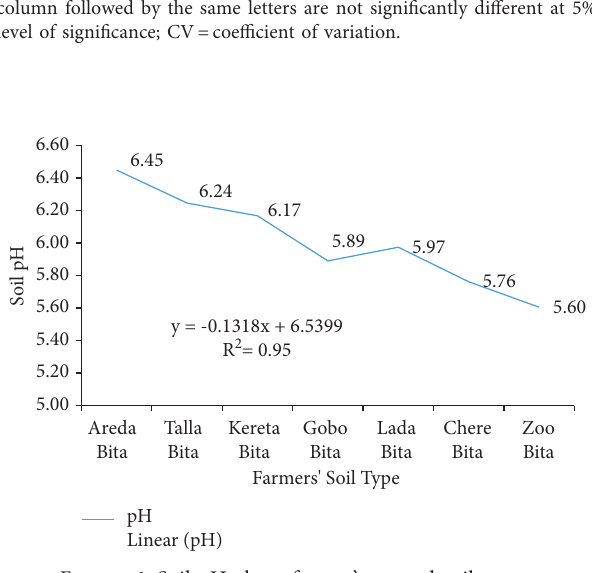
Figure 6: Soil pH along farmer’s named soil